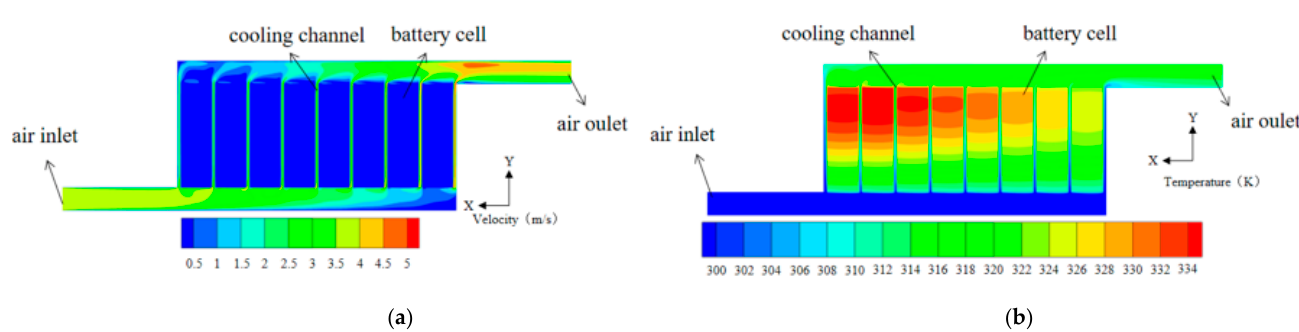
Figure 6. Flow and temperature fields of the basic model; ( a ) velocity contour of the basic model; ( b ) temperature contour of the basic model.